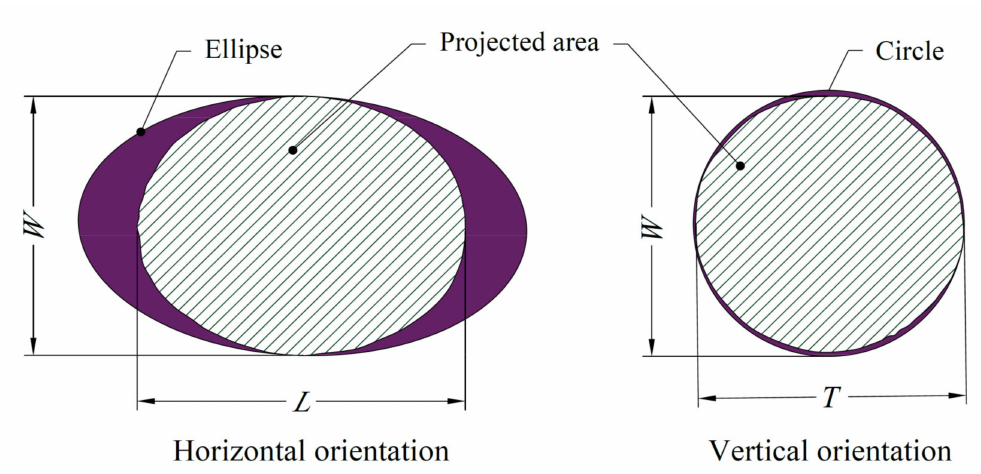
Figure 2. Image acquisition system.